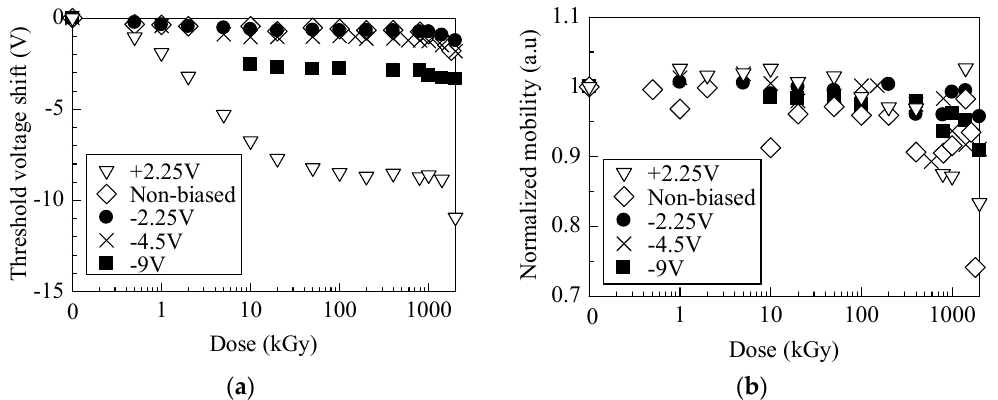
Figure 2. Plots of ( a ) the threshold voltage shift and ( b ) normalized mobility as a function of dose.